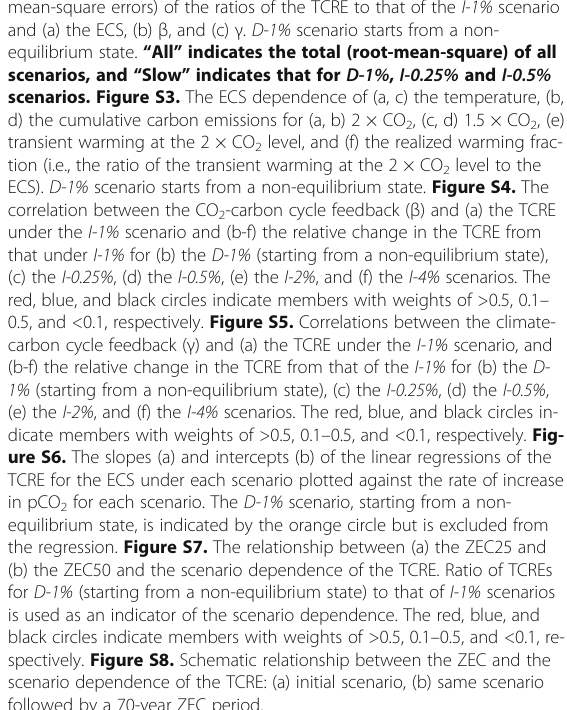
Figure S2. The weighted relationships between the deviations (root- mean-square errors) of the ratios of the TCRE to that of the I-1% scenario and (a) the ECS, (b) β , and (c) γ . D-1% scenario starts from a non- equilibrium state. “ All ” indicates the total (root-mean-square) of all scenarios, and “ Slow ” indicates that for D-1% , I-0.25% and I-0.5% scenarios. Figure S3. The ECS dependence of (a, c) the temperature, (b, d) the cumulative carbon emissions for (a, b) 2 × CO 2 , (c, d) 1.5 × CO 2 , (e) transient warming at the 2 × CO 2 level, and (f) the realized warming frac- tion (i.e., the ratio of the transient warming at the 2 × CO 2 level to the ECS). D-1% scenario starts from a non-equilibrium state. Figure S4. The correlation between the CO 2 -carbon cycle feedback ( β ) and (a) the TCRE under the I-1% scenario and (b-f) the relative change in the TCRE from that under I-1% for (b) the D-1% (starting from a non-equilibrium state), (c) the I-0.25% , (d) the I-0.5% , (e) the I-2% , and (f) the I-4% scenarios. The red, blue, and black circles indicate members with weights of >0.5, 0.1 – 0.5, and <0.1, respectively. Figure S5. Correlations between the climate- carbon cycle feedback ( γ ) and (a) the TCRE under the I-1% scenario, and (b-f) the relative change in the TCRE from that of the I-1% for (b) the D- 1% (starting from a non-equilibrium state), (c) the I-0.25% , (d) the I-0.5% , (e) the I-2% , and (f) the I-4% scenarios. The red, blue, and black circles in- dicate members with weights of >0.5, 0.1 – 0.5, and <0.1, respectively. Fig- ure S6. The slopes (a) and intercepts (b) of the linear regressions of the TCRE for the ECS under each scenario plotted against the rate of increase in pCO 2 for each scenario. The D-1% scenario, starting from a non- equilibrium state, is indicated by the orange circle but is excluded from the regression. Figure S7. The relationship between (a) the ZEC25 and (b) the ZEC50 and the scenario dependence of the TCRE. Ratio of TCREs for D-1% (starting from a non-equilibrium state) to that of I-1% scenarios is used as an indicator of the scenario dependence. The red, blue, and black circles indicate members with weights of >0.5, 0.1 – 0.5, and <0.1, re- spectively. Figure S8. Schematic relationship between the ZEC and the scenario dependence of the TCRE: (a) initial scenario, (b) same scenario followed by a 70-year ZEC